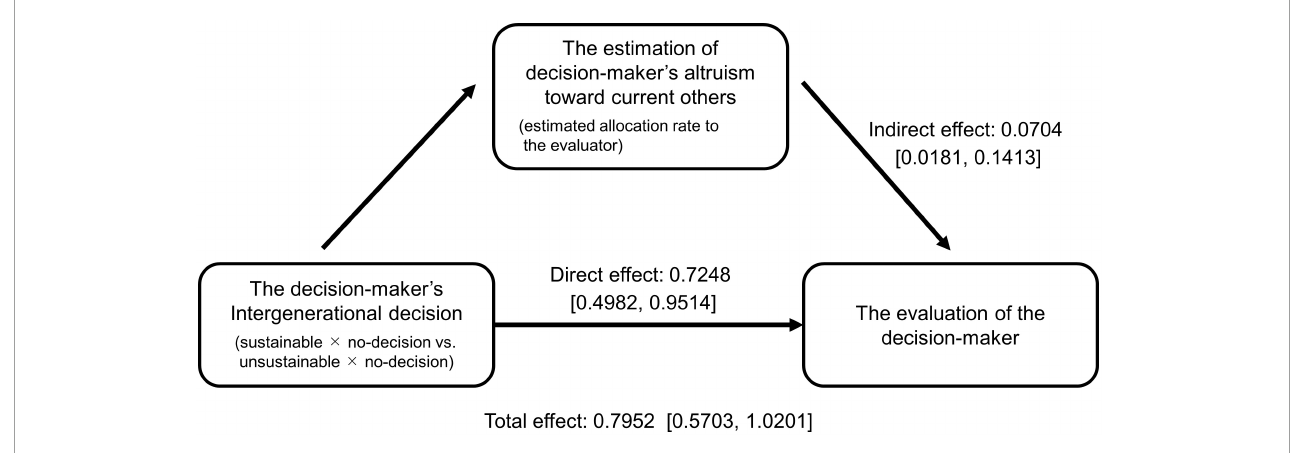
FIGURE6 The result of the mediation analysis in Study 2. The values in the brackets are the confidence